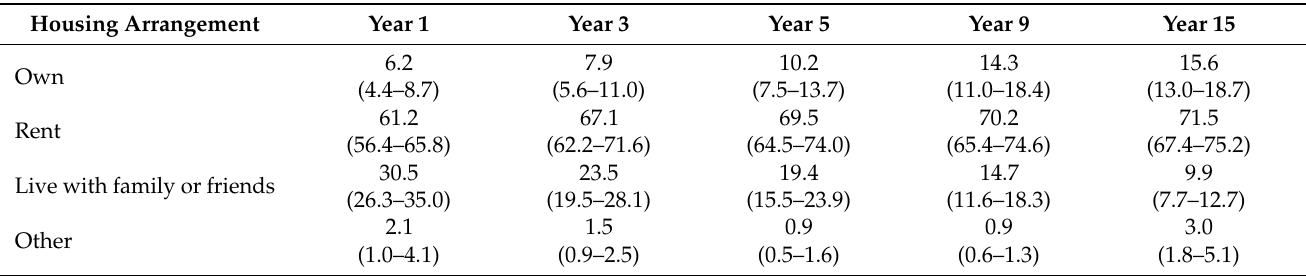
Table 2. Weighted percentages of housing arrangements among US mothers following a nonmarital birth, Fragile Families and Child Wellbeing Study ( n =